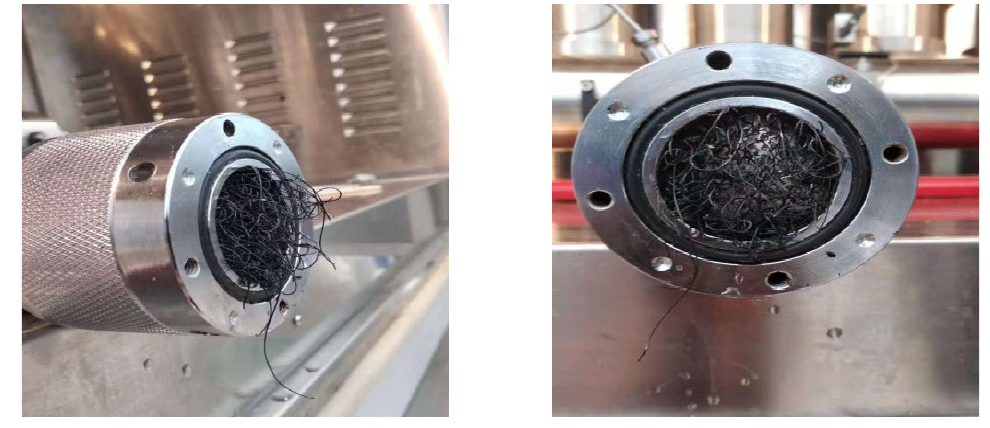
Figure 9. Particle Via Experiment.